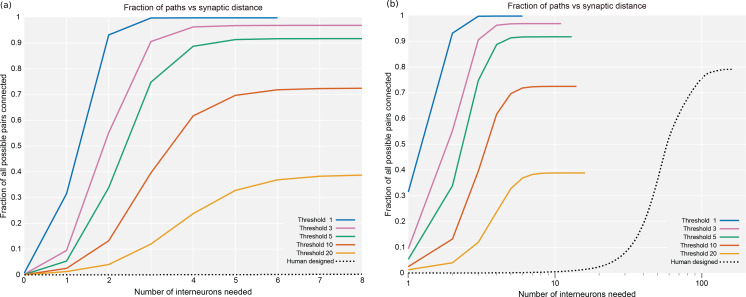
Plots of the percentage of pairs connected (of all possible) versus the number of interneurons required.(a) It shows the data from the whole hemibrain, for up to eight interneurons. (b) It is a much wider view of the same data, shown on a log scale so the curve from a human designed system is visible. Data available in Figure 20—source datas 1–6.Figure 20—source data 1.Data for threshold 1 trace.The first column is the path length between two nodes, the second the number of pairs for which that is the length of the shortest path between them, and the third the cumulative fraction of all paths of that length or less.Figure 20—source data 2.Data for threshold 3.The first column is the path length between two nodes, the second the number of pairs for which that is the length of the shortest path between them, and the third the cumulative fraction of all paths of that length or less.Figure 20—source data 3.Data for threshold 5 trace.The first column is the path length between two nodes, the second the number of pairs for which that is the length of the shortest path between them, and the third the cumulative fraction of all paths of that length or less.Figure 20—source data 4.Data for threshold 10 trace.The first column is the path length between two nodes, the second the number of pairs for which that is the length of the shortest path between them, and the third the cumulative fraction of all paths of that length or less.Figure 20—source data 5.Data for threshold 20 trace.The first column is the path length between two nodes, the second the number of pairs for which that is the length of the shortest path between them, and the third the cumulative fraction of all paths of that length or less.Figure 20—source data 6.Data for human designed trace.The first column is the path length between two nodes, the second the number of pairs for which that is the length of the shortest path between them, and the third the cumulative fraction of all paths of that length or less.